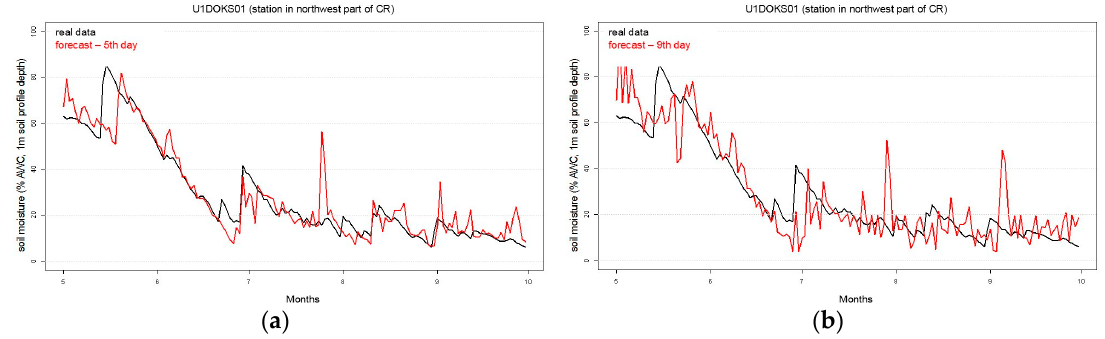
Figure 10. BIAS ( a ) and MAE (mean absolute error) ( b ) evaluated from daily differences of values of soil water content (in % AWC, grassland, 1 m soil depth with AWC = 170 mm) calculated from forecast data and real measured data for year (YEAR), for the spring (MAM—March, April, May) and summer season (JJA—June, July, August) from the 1st to 9th day of the forecast in the year 2017.